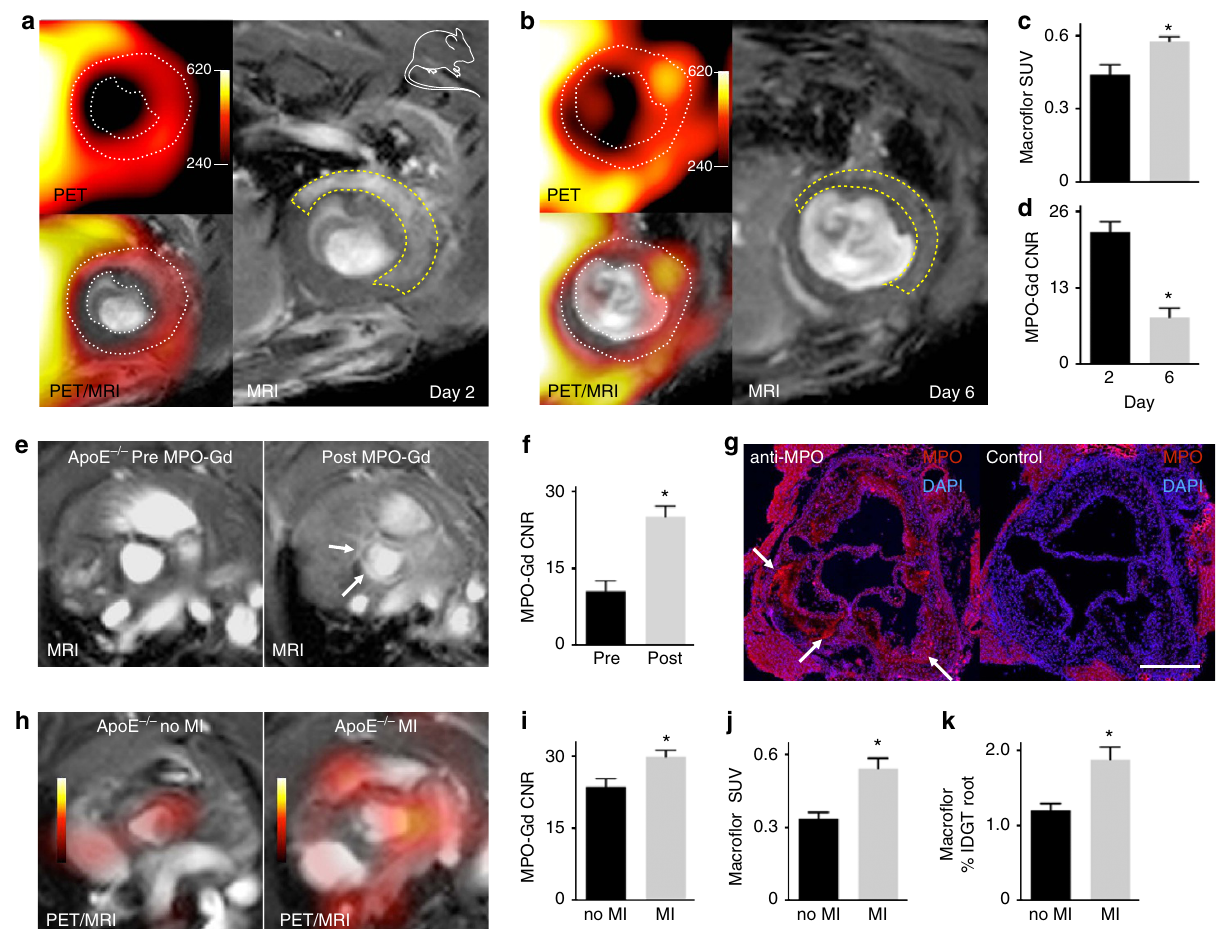
Figure 6 | Dual channel macrophage PET/MRI in ischaemic heart disease. Imaging macrophages and myeloperoxidase detects different inflammatory phenotypes. ( a ) PET/MRI on day 2 and ( b ) day 6 post MI in wild-type mice. White dotted line on PET/MRI outlines myocardium. Yellow dashed line on MRI outlines the infarct identified by gadolinium enhancement and wall motion abnormality in cine loops. ( c ) In vivo PET standard uptake value (SUV) in infarct zone on days 2 and 6 post MI ( n ¼ 4 per group, unpaired t -test). ( d ) In vivo MRI contrast to noise ratio (CNR) in infarct 90min after IV MPO-Gd injection ( n ¼ 4 per group, unpaired t -test). ( e ) MRI of aortic root in ApoE (cid:2) / (cid:2) mouse before and 90min after IV MPO-Gd. Arrows indicate enhancement in the aortic root. ( f ) Quantified MRI contrast to noise ratio (CNR) before and after MPO-Gd administration ( n ¼ 8 per group, unpaired t -test). ( g ) Immunofluorescent staining for the MR imaging target myeloperoxidase (MPO) in aortic root of ApoE (cid:2) / (cid:2) mouse. Control stain: omission of primary antibody on an adjacent slide. Scale bar, 500 m m. Representative image of n ¼ 4 ApoE (cid:2) / (cid:2) mice. ( h ) PET/MRI following systemic administration of Macroflor and MPO-Gd in ApoE (cid:2) / (cid:2) mice without and 3 weeks after MI ( n ¼ 4–5). ( i ) MPO-Gd MRI contrast to noise ratio (CNR) in aortic roots of ApoE (cid:2) / (cid:2) mice with and without MI. ( j ) In vivo PET SUV of aortic root after IV Macroflor injection ( n ¼ 4–5 per group, unpaired t -test). ( k ) Ex vivo scintillation counting of aortae harvested from ApoE (cid:2) / (cid:2) mice after IV Macroflor injection ( n ¼ 4–5 per group, unpaired t -test). Data are shown as mean ± s.e.m., * indicates P o 0.05. Mouse cartoon image is reproduced from the servier medical art image data bank (http://www.servier.com/